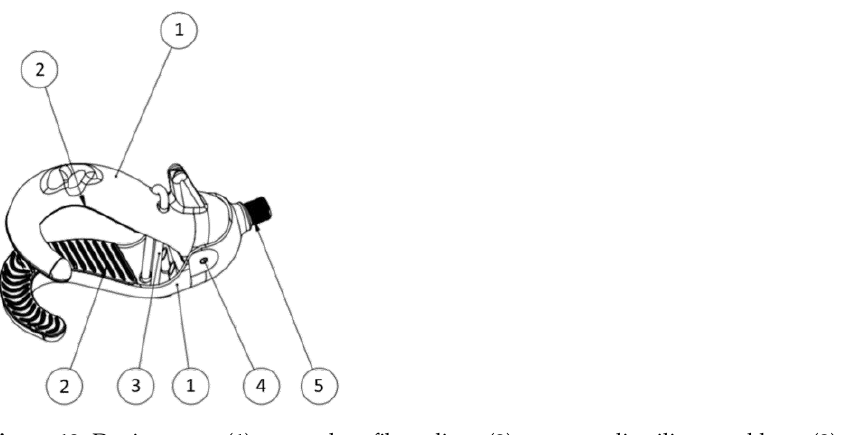
Figure 13. Device parts: ( 1 ) two carbon fiber pliers; ( 2 ) two non-slip silicone rubbers; ( 3 ) latex tubu- lar band; ( 4 ) stainless steel shaft with ABS plastic coating; and ( 5 ) stainless steel fine